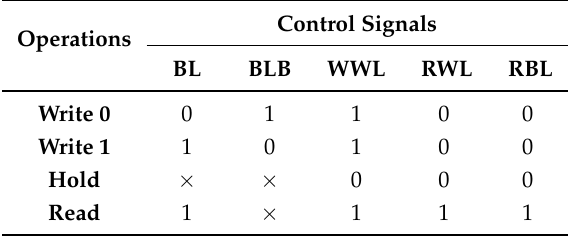
Table 1. Control signals of proposed AS10T SRAM cell for different operations. Write ’0’ and Write ’1’ correspond to the storage node Q. BL and BLB are the bit-lines and are complementary to each other. RBL is bit-line during read operation. WWL and RWL are the word-lines during write and read operations,